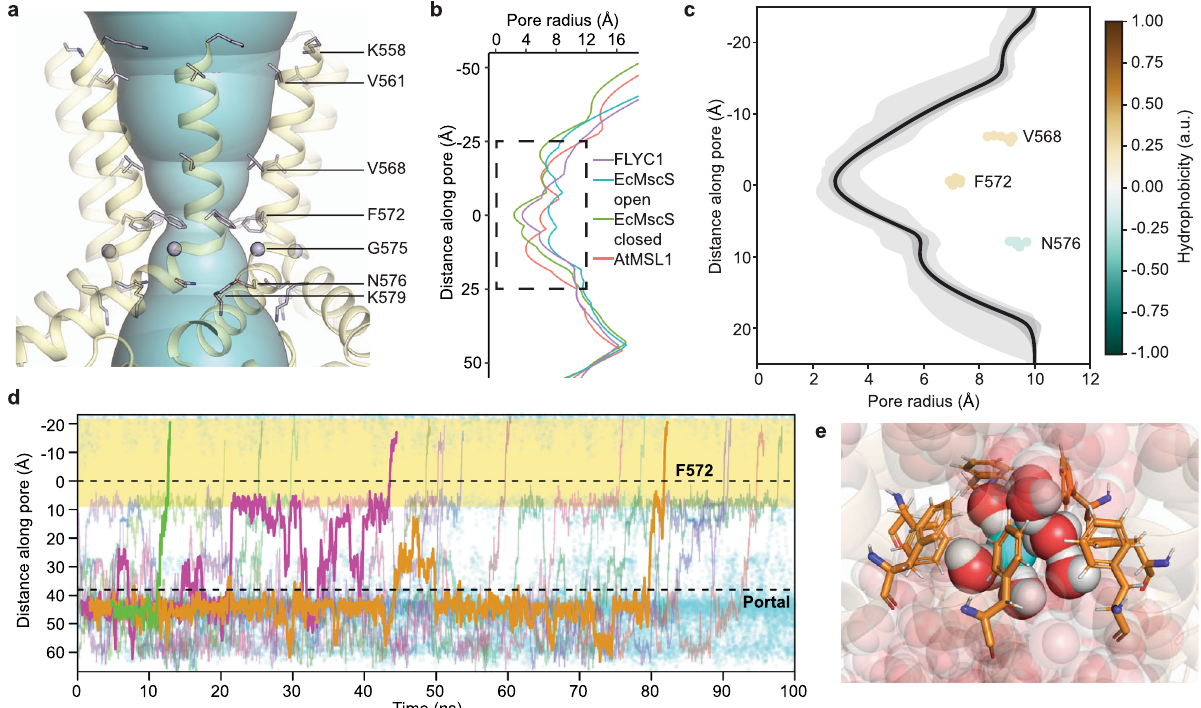
Fig. 2 Pore of FLYC1. a Depiction of central pore along the TM domain, with pore lining residues (shown as sticks, except for G575 which is shown as a sphere) labeled. b Pore pro fi le of FLYC1, closed AtMSL1 and EcMscS in open (PDB: 5AJI) and closed states. Box represents area of ( c ). c Radius pro fi le of FLYC1 pore (TM region) during a 100 ns protein backbone-restrained simulation. The dark gray region covers the maximum and minimum radii of the position, while the light gray region covers a region of mean radius ± 1 s.d. Positions of the pore-lining residues (center of mass) from the pore axis are labelled. d Trajectories of Cl – traversing the channel completely during simulation in the presence of a − 425 mV transmembrane potential difference, shown as their coordinates along the pore ( z ) axis. Each colored trace represents a different Cl – , while all Cl – inside the channel is depicted in cyan. Three representative trajectories are highlighted in the foreground. The pore region lined by TM6a (from K558 to N576) is highlighted in yellow. The locations of the F572 ring and the cytoplasmic portal are also marked as dashed lines. One of our three independent simulations is shown for ( c and d ). e A representative snapshot of Cl – ion crossing event through the F572 ring, during which dewetting behavior is not